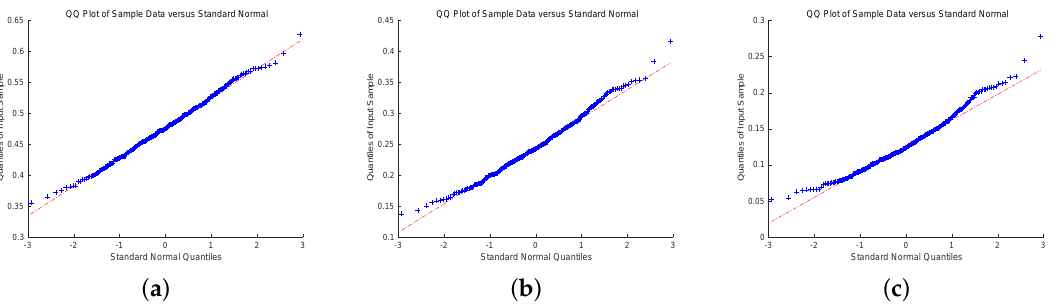
Figure 1. QQ-plot of RP for Exponential claim size density with T = 720: ( a ) u = 1; ( b ) u = 3; ( c ) u = 5.